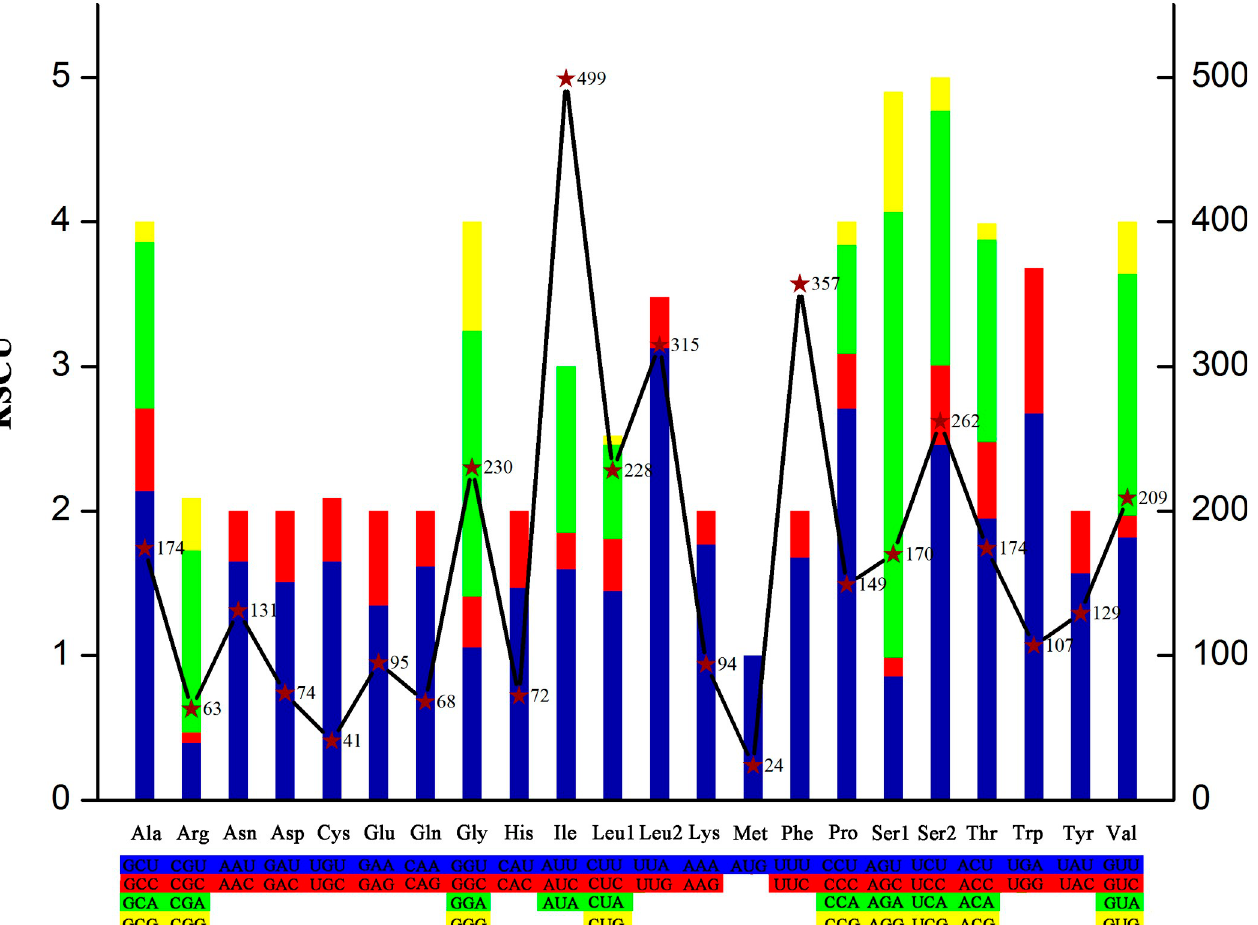
Fig 2. RSCU and Codon distribution in the mitogenome of L . vittata . The left ordinate represents RSCU, and the right ordinate represents the number of the Codon distribution.